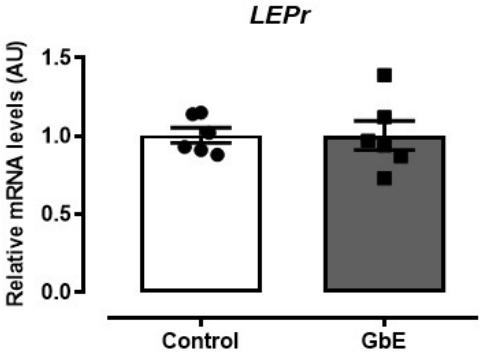
Figure 3. Relative mRNA levels of the leptin receptor (LEPr) in the hypothalamus. Control ( n = 6) 3.4. Protein Levels of POMC, 5-HT1B, and 5-HT2C Protein levels of POMC, 5-HT1B, and 5-HT2C are depicted in Figure 4. A single acute administration of GbE failed to modify the hypothalamic levels of POMC ( p = 0.818), 5-HT1B ( p = 0.436), or 5-HT2C ( p = 0.486).